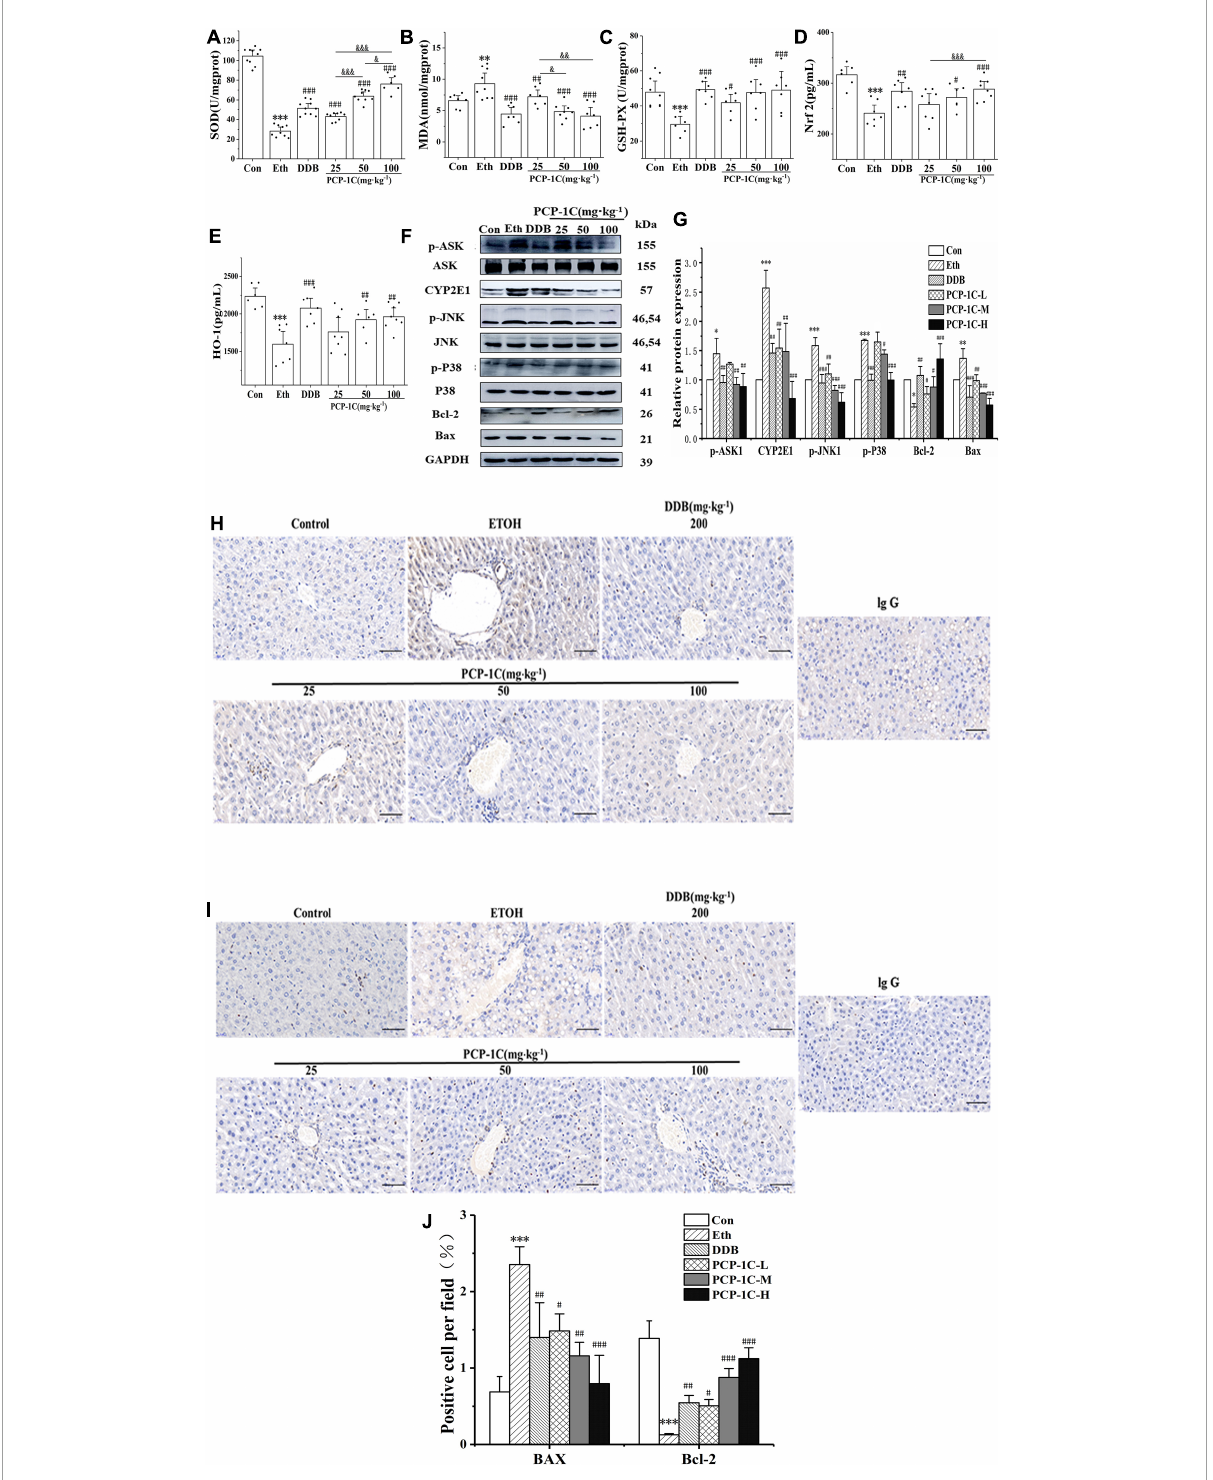
FIGURE4 Effect of PCP-1C on oxidative stress and apoptosis in ALD mice. (A) Hepatic SOD levels. The serum levels of (B) MDA, (C) GSH-Px, (D) Nrf2, and (E) HO-1. (F) Representative immunoblot images of CYP2E1 and related proteins are involved in the apoptosis pathway in liver tissues. (G) Relative protein levels of CYP2E1 and related proteins involved in the apoptosis pathway. (H–J) Immunohistochemical staining of Bax and Bcl-2 in liver tissue. The results are presented as mean ± SD. ∗ P < 0.05, ∗∗ P < 0.01, ∗∗∗ P < 0.001 vs. control group; # P < 0.05, ## P < 0.05, ### P < 0.001 vs. model group. & P < 0.05, && P < 0.01, &&& P < 0.001 represents significance between PCP-1C